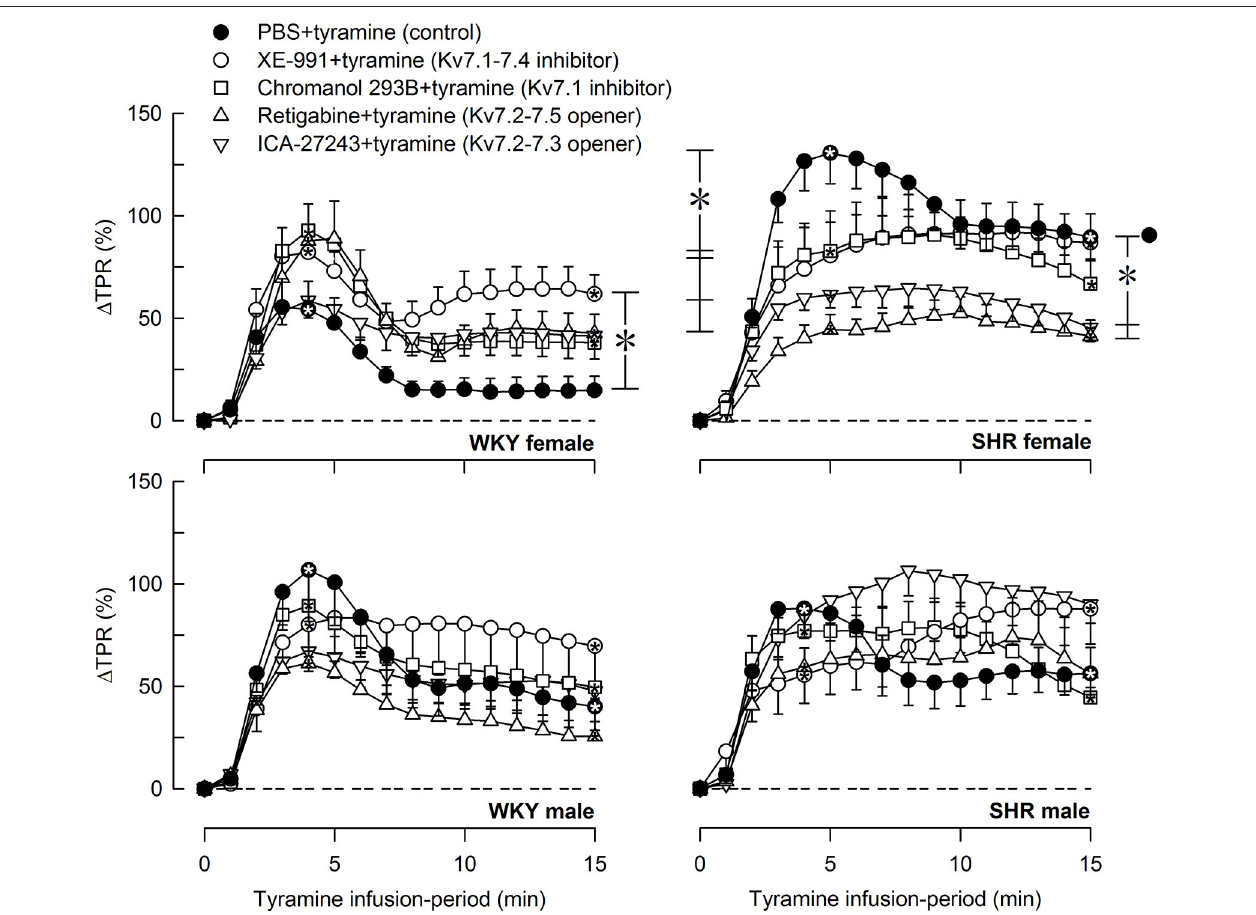
FIGURE 6 | The effect of Kv7 inhibitors/openers on the TPR-response to tyramine-stimulated norepinephrine release. The rats were pre-treated as indicated by symbol legends. Analyses of the tyramine-response curves using Repeated Measures Analyses of Variance and Covariance indicated the presence of significant responses in all four sets of experiments, as well as the presence of differences between the control and the experimental groups within the female WKY and SHR rats, but not male rats. Significant responses, i.e., differences compared to base-line (* within symbol), were subsequently located as indicated by one-sample Student’s t -tests at the initial TPR-peak-response, i.e., at 4min, and at the end of the tyramine-infusion, i.e., at 15min. Significant differences between the control and the drug-treated, experimental groups within each set of experiments were located by two-sample Student’s t - or Kruskal–Wallis tests at 4min (* within brackets left of curves) and at 15min (* within brackets right of curves) as indicated. In the order of symbol legends, TPR prior to tyramine = 3.0 ± 0.2, 2.4 ± 0.2, 2.5 ± 0.2, 2.5 ± 0.1, 2.1 ± 0.2mm Hg/ml/min in the female WKY groups, 3.2 ± 0.3, 4.1 ± 0.5, 3.4 ± 0.4, 4.3 ± 0.4, 5.3 ± 0.4mm Hg/ml/min in the female SHR groups, 2.1 ± 0.2 † ,1.7 ± 0.1, 2.8 ± 0.2 ‡ , 1.9 ± 0.2, 2.7 ± 0.3mm Hg/ml/min in the male WKY groups, and 4.4 ± 0.3* † , 3.2 ± 0.2 ‡ , 5.2 ± 0.6, 3.5 ± 0.3, 4.5 ± 0.5mm Hg/ml/min in the male SHR groups ( P ≤ 0.0125 for strain- (*), sex- ( † ), or drug- ( ‡ ) related differences in the baselines). * within symbol and brackets — P ≤ 0.025 (please see the Materials and Methods section for further